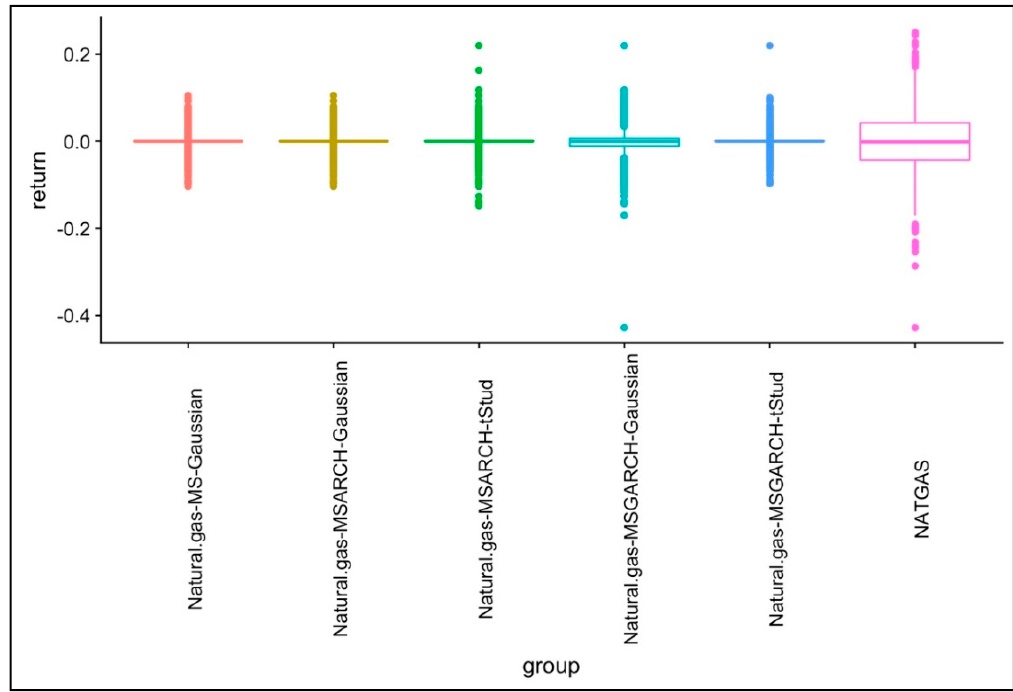
Figure 4. Box plot of the returns of five simulated scenarios in the natural gas continuous. Source: Own elaboration with results of our simulations and data from Refinitiv Eikon [72].